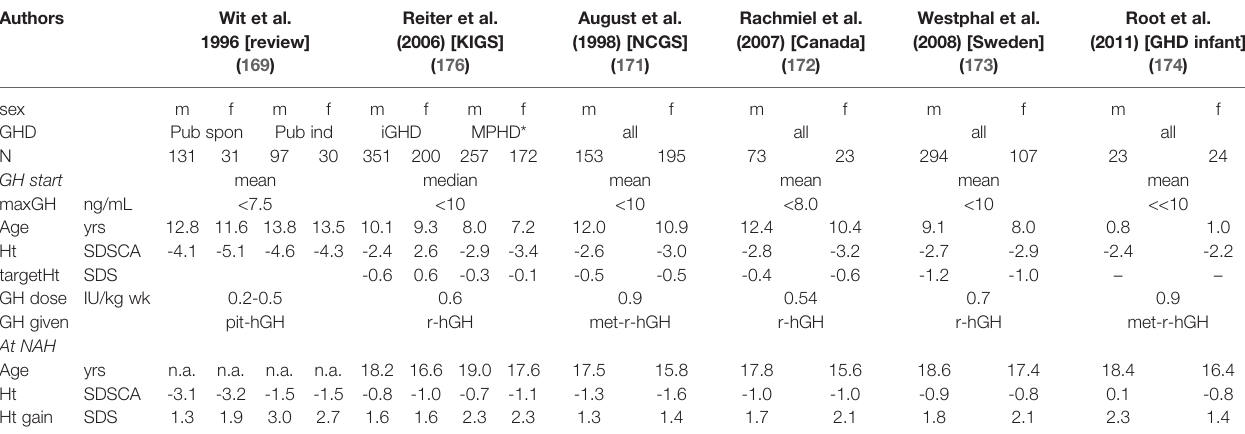
TABLE 4 | Examples of groups of non-acquired GHD patients treated to NAH.